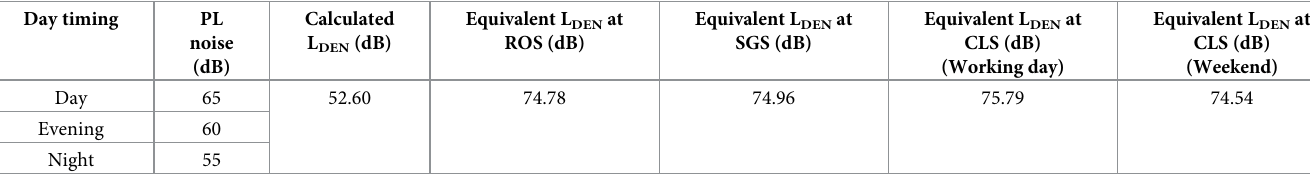
Table 13. The comparison between the permissible limit for noise levels allowed by the International Organization for Standardization (ISO) [30] [31] [32] and the Egyptian Environmental Law No. 4/1994 [13] and the equivalent mean LDEN calculated by equation (1) in Table 12. Day timing